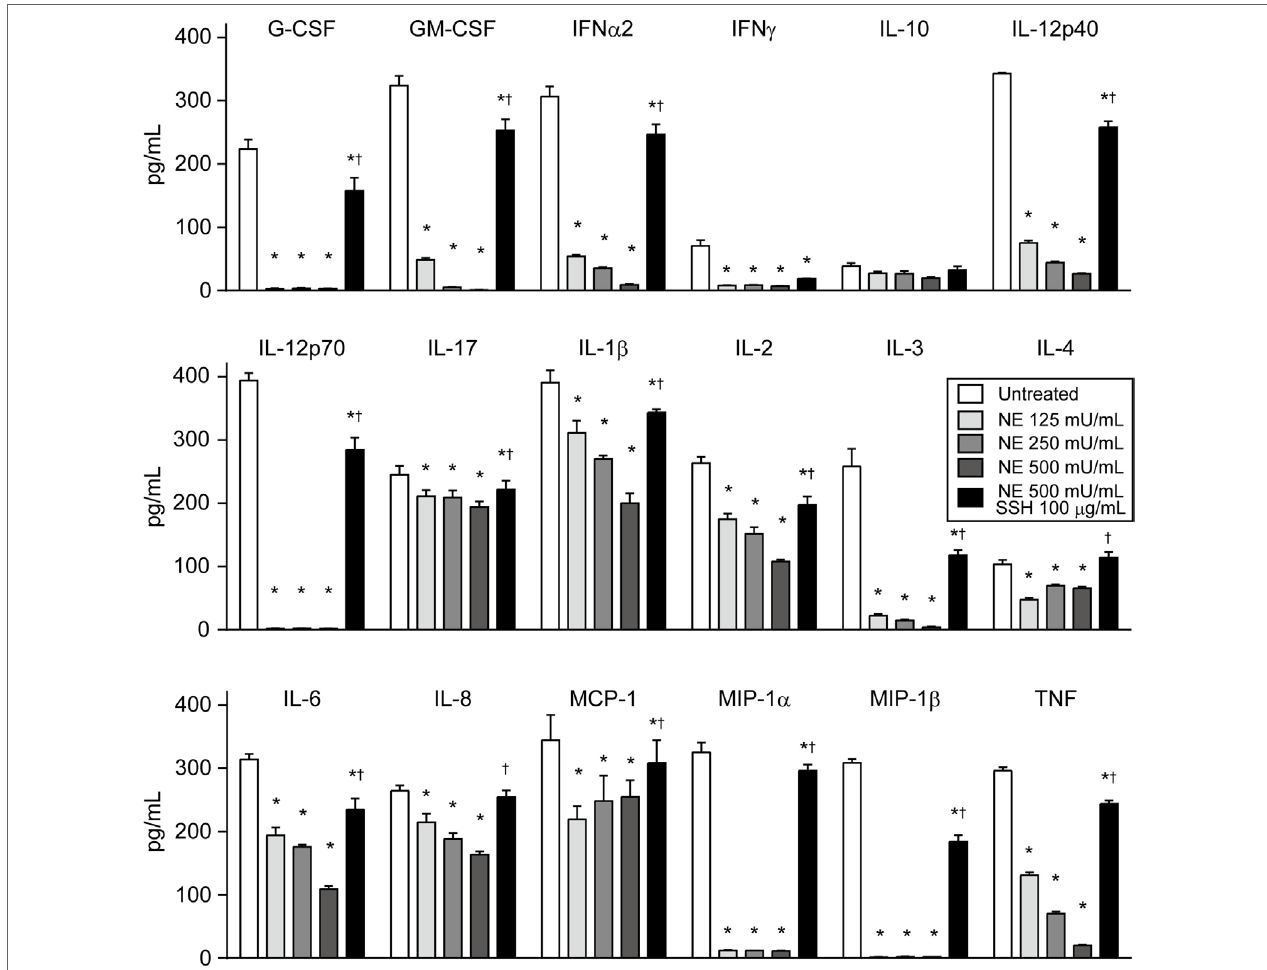
FigUre 5 | Multiplex assay reveals that neutrophil elastase (NE) degrades various cytokines. Human cytokine/chemokine cocktail was exposed to hNE (125– 500 mU/mL) in the presence or absence of SSH (100 µg/mL) for 3 h. Then, cytokines were detected using a multiplex assay. Data represent the mean ± SD of quadruplicate experiments and were evaluated using two-way ANOVA. *Significantly different from the hNE-untreated control at P < 0.05. † Significantly different from the hNE-treated (500 mU/mL) group in the absence of SSH at P < 0.05. hNE, human neutrophil elastase; SSH, sivelestat sodium